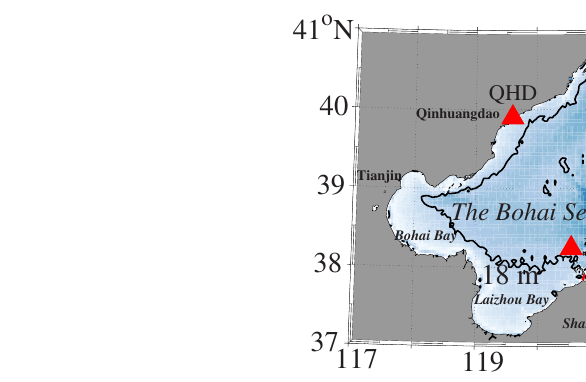
observations. The in-situ observed SST has been stored as the 10- day average record. Due to the differences in sampling intervals, the remote sensing SST has more fl uctuations which caused the RMS